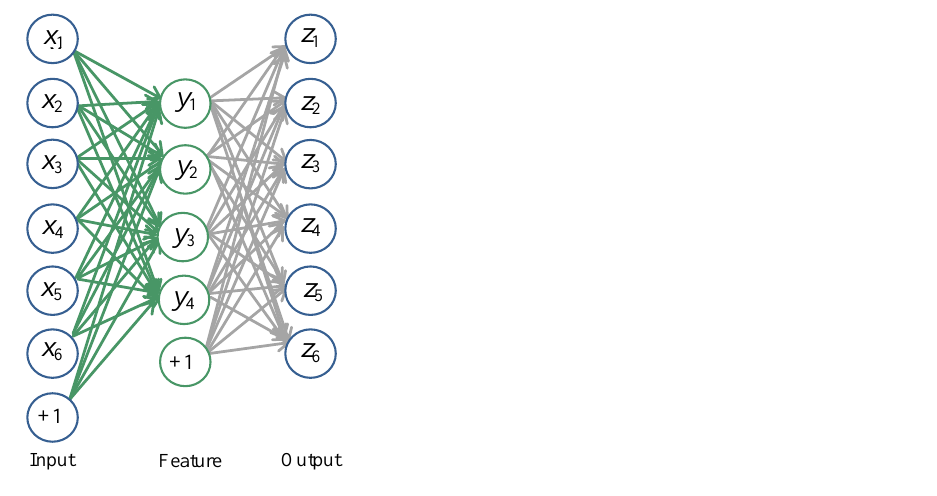
Figure 1. An example of the basic AE with 6 input units and 4 hidden units (features). From left to right, respectively, the input layer, the hidden layer, and the output layer. x i is an input unit, y j is a hidden unit, and z i is an output unit. The number “1” denotes bias. Connections are exclusively drawn between different